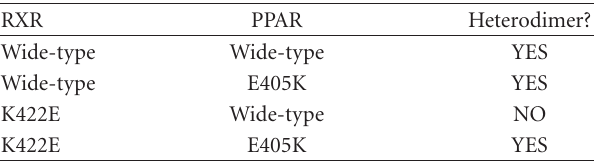
Table 2: Altered heterodimerization properties of the RXR and PPAR charge-reversal